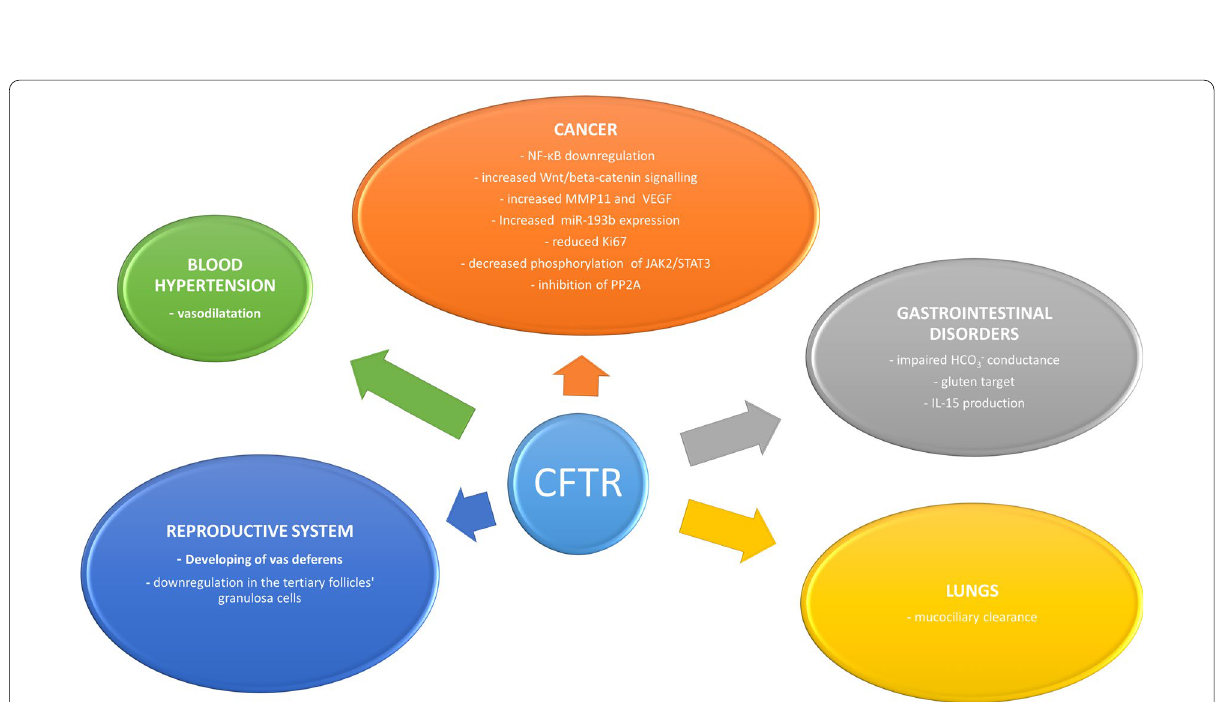
Fig. 1 Summary of main functions of the